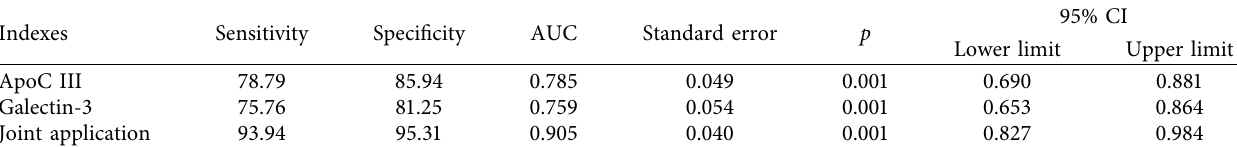
Table 3: The value of ApoC III and galectin-3 in predicting pregnancy outcome in patients with GDM.